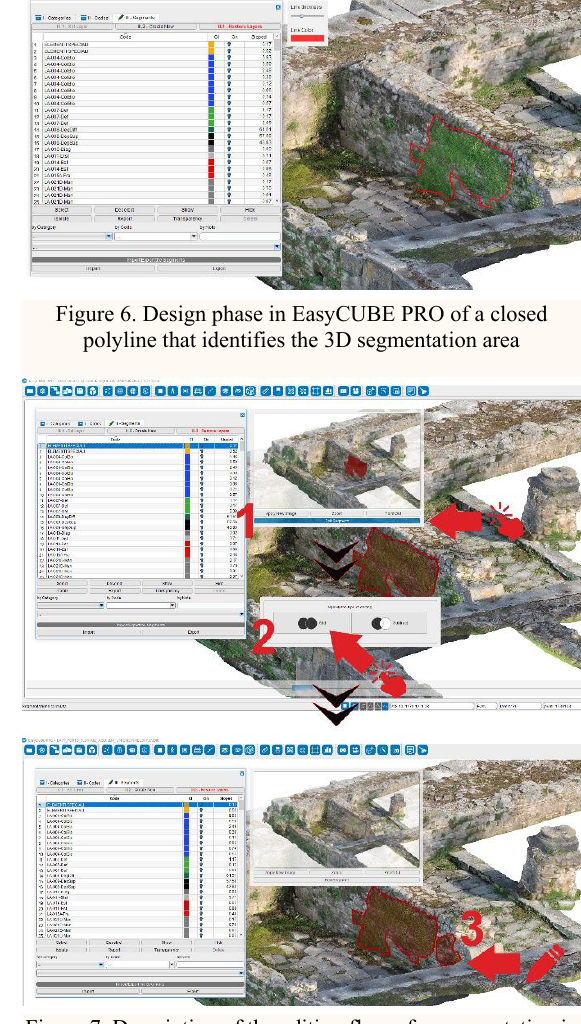
Figure 7. Description of the editing flow of a segmentation in EasyCUBE PRO, in this case with the addition of a portion